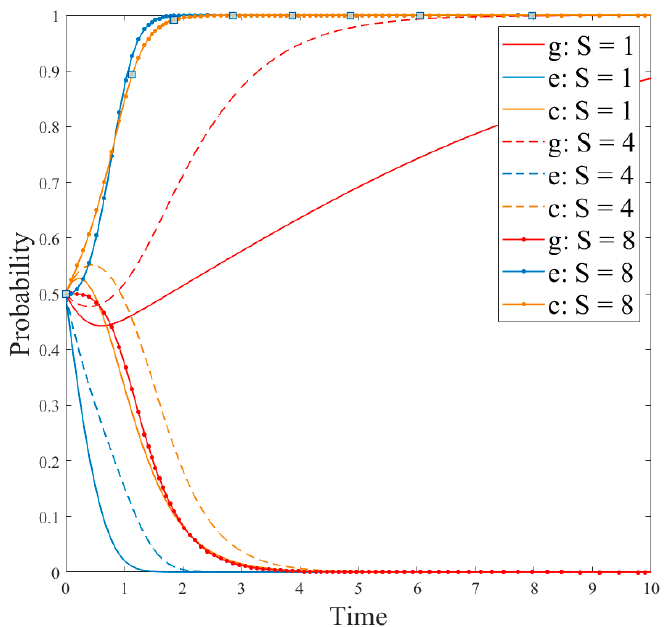
Figure 9. Evolution results of the system strategy with different subsidy(S) ( g : government, e : enter ‐ prise, c : consumer) ( S :production subsidies or tax ‐ free subsidies obtained by enterprises investing in research and development).